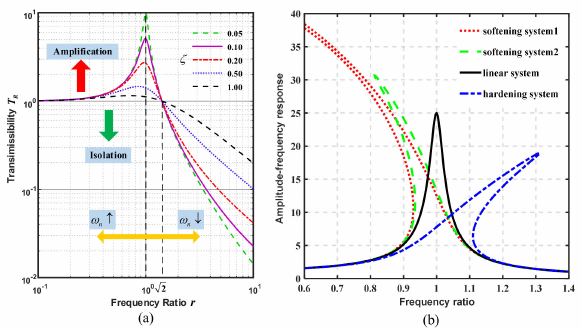
Figure 4. Response curves: ( a ) Transmissibility; ( b ) Amplitude-frequency